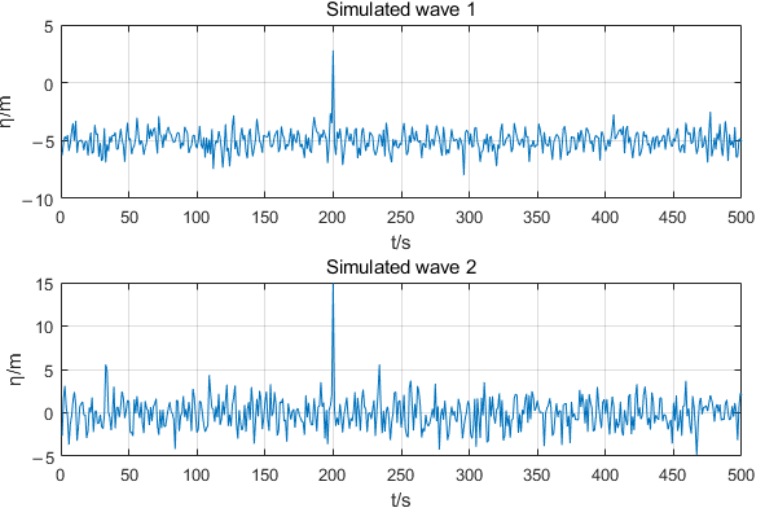
Figure 1. Simulated wave 1 and simulated wave 2 generated by JONSWAP spectrum based on phase modulation method.